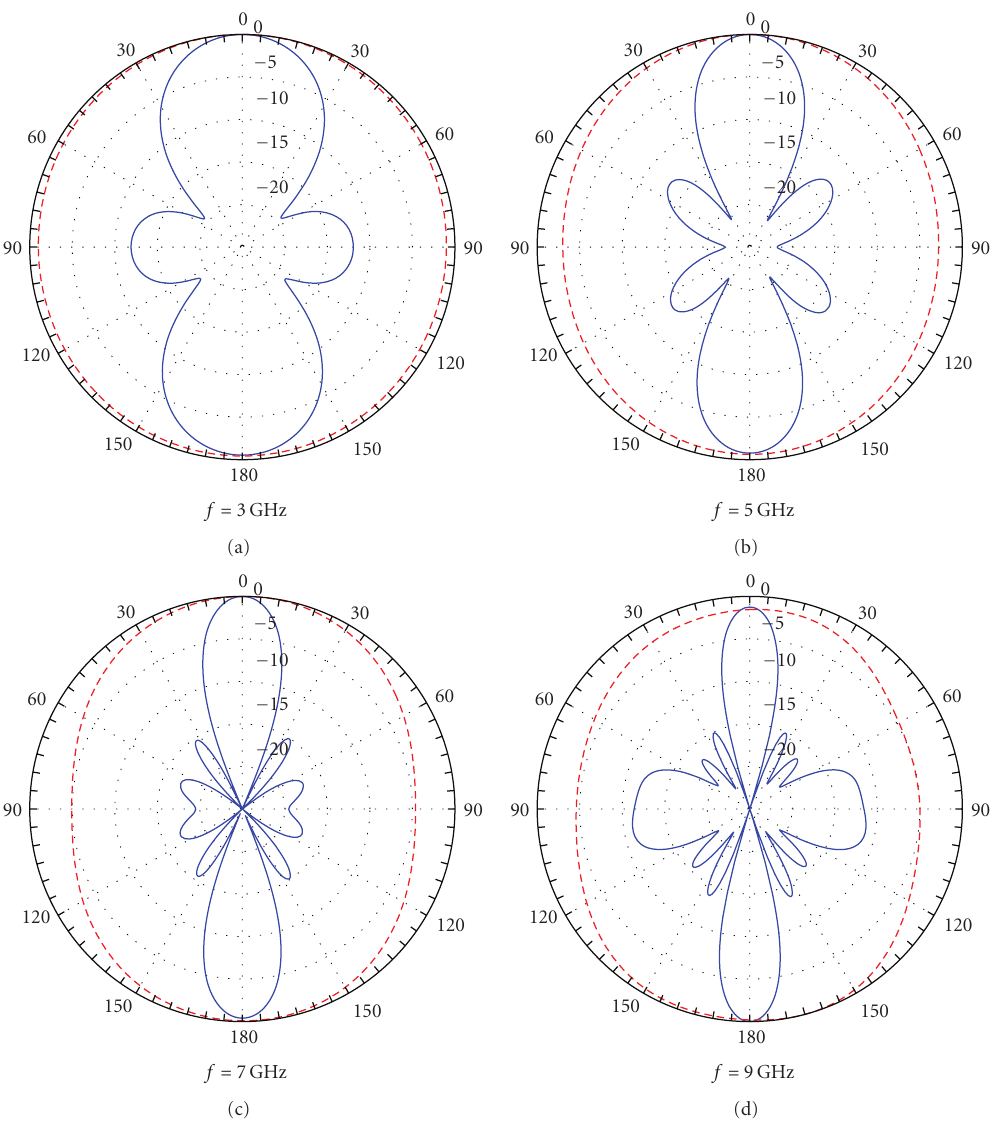
Figure 20: Simulated H -plane ( YZ -plane) radiation patterns for the four-element UWB array at element spacing d = 28 mm (solid line) compared to a single antenna element (dashed line).